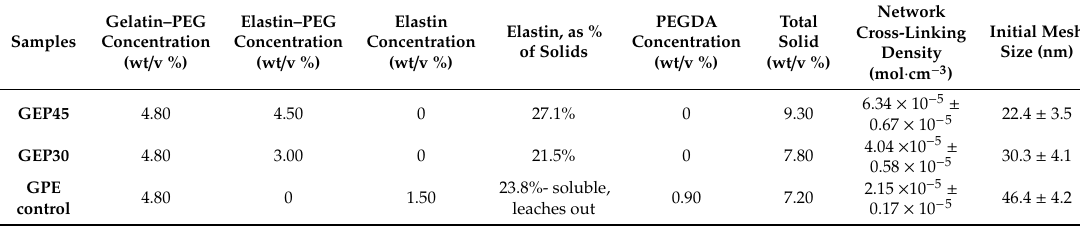
Table 1. The composition of GEP45, GEP30 and GPE control hydrogels. GPE control contains physically incorporated soluble elastin, gelatin–PEG precursor (4.80%(wt / v)) and 0.90%(wt / v) PEGDA (PEG diacrylate). Soluble elastin and PEGDA were covalently conjugated to the elastin–PEG precursor before fabricating GEP45 and GEP30, while PEGDA was added to GPE control to have similar mechanical properties as GEP45 and GEP30. The network cross-linking density was calculated from the rubber elastic theory. The mesh size was calculated based on the initial storage moduli and swelling ratio. (n = 3, p <